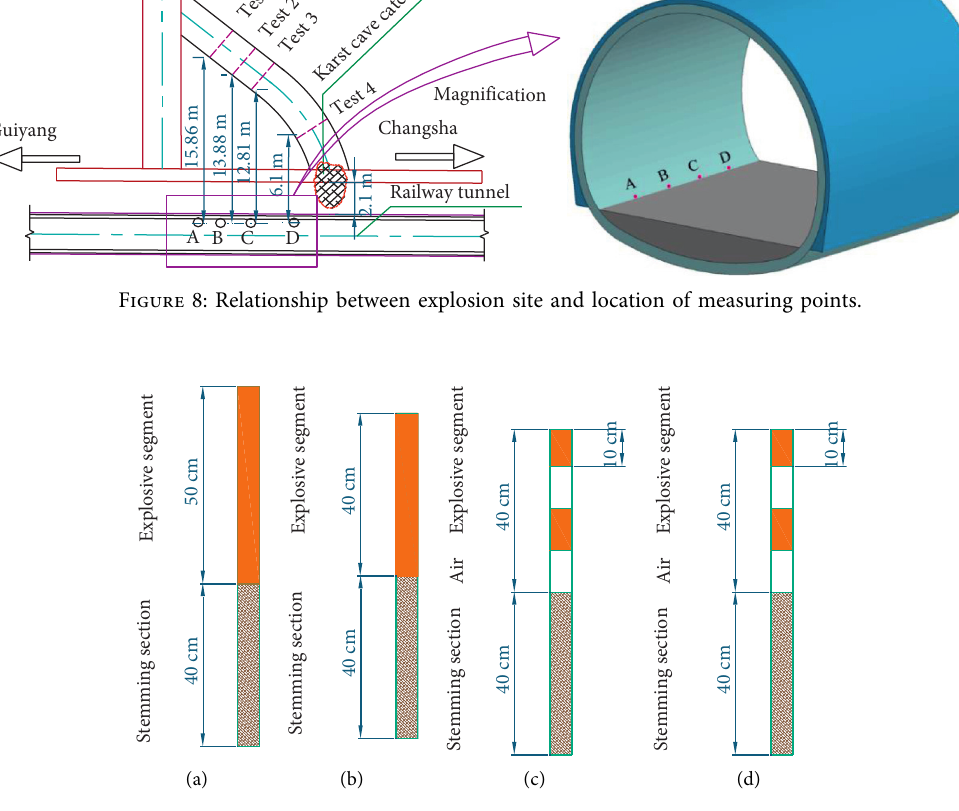
Figure 9: The charging structure: (a) charging for cut holes, (b) charging for auxiliary holes, (c) charging for periphery holes, and (d) charging for bottom holes. Table 1: Blasting parameters. (1) Conventional blasting